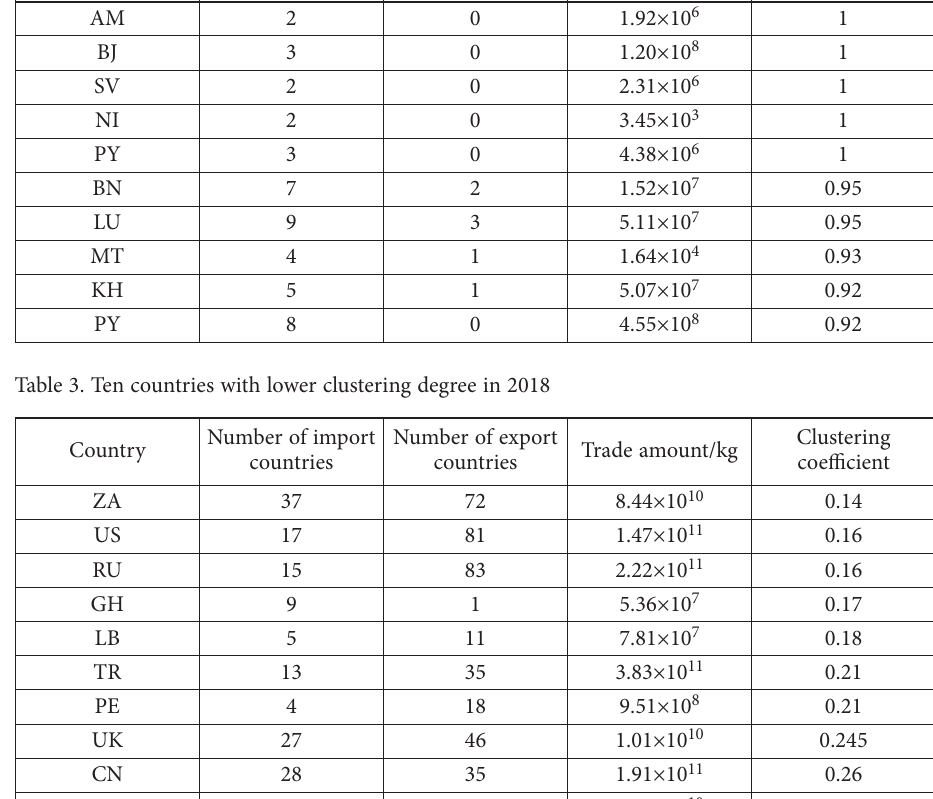
Table 2. Ten countries with higher clustering degree in 2018 Number of import Number of export Trade amount/Kg Country countries countries